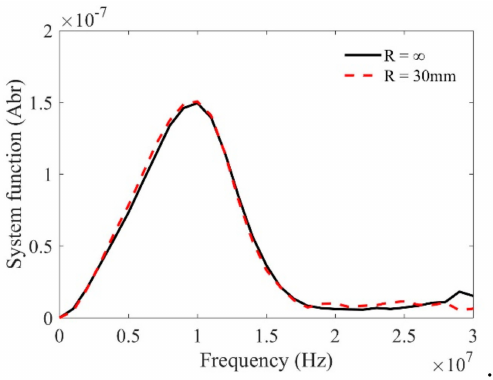
Figure 8. Calibrated system function using the above measured reference signals in Figure 7.